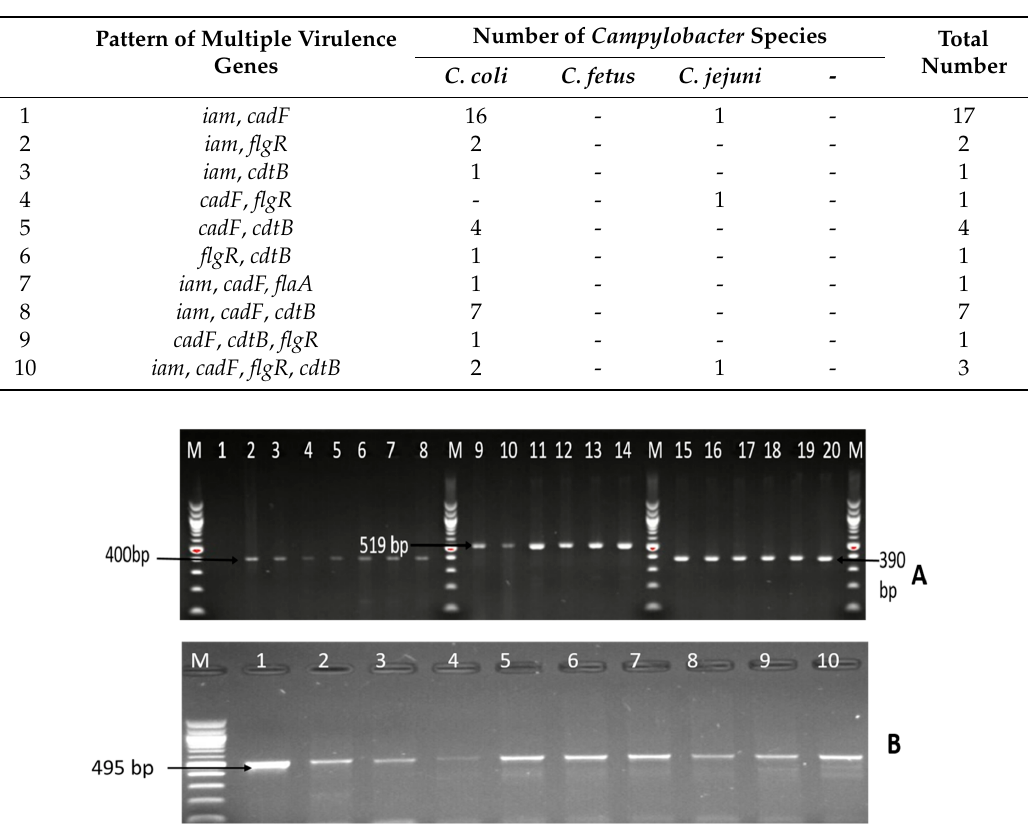
Table 4. Patterns of occurrence of multiple virulence genes in the identified species.